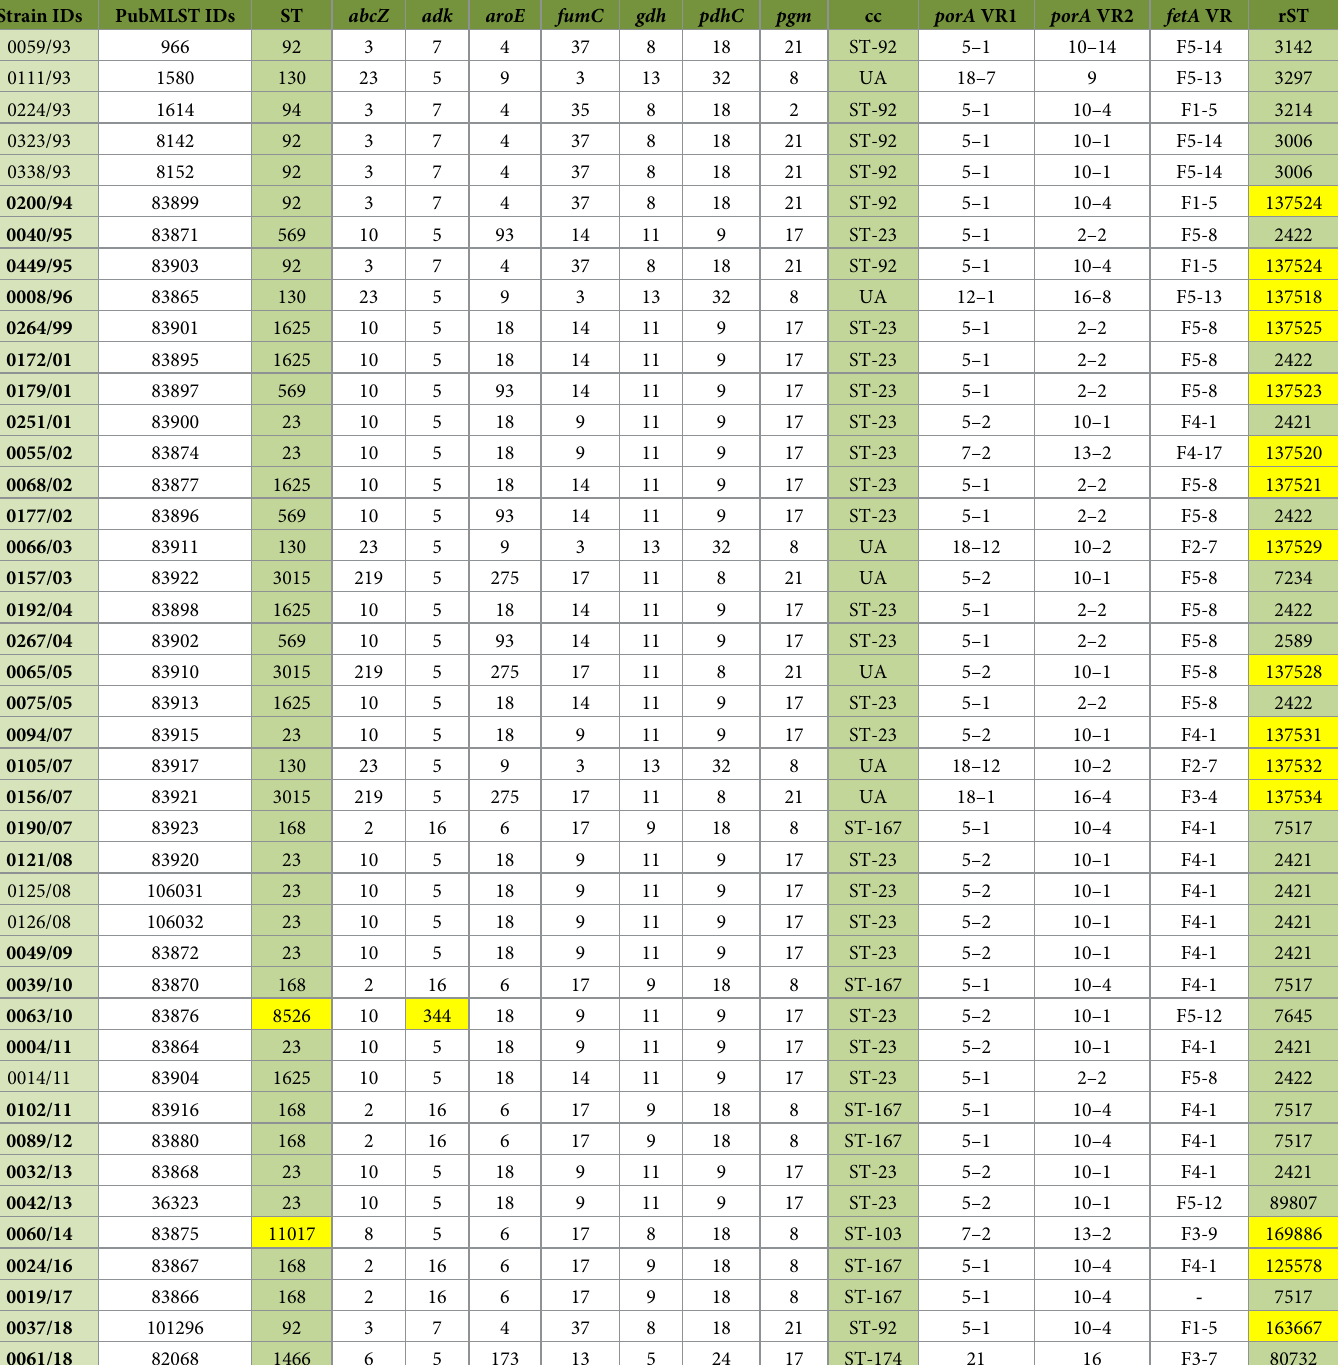
Table 1. Basic molecular characterization of N . meningitidis Y isolates collected in the Czech Republic from 1993 to 2018, (n =